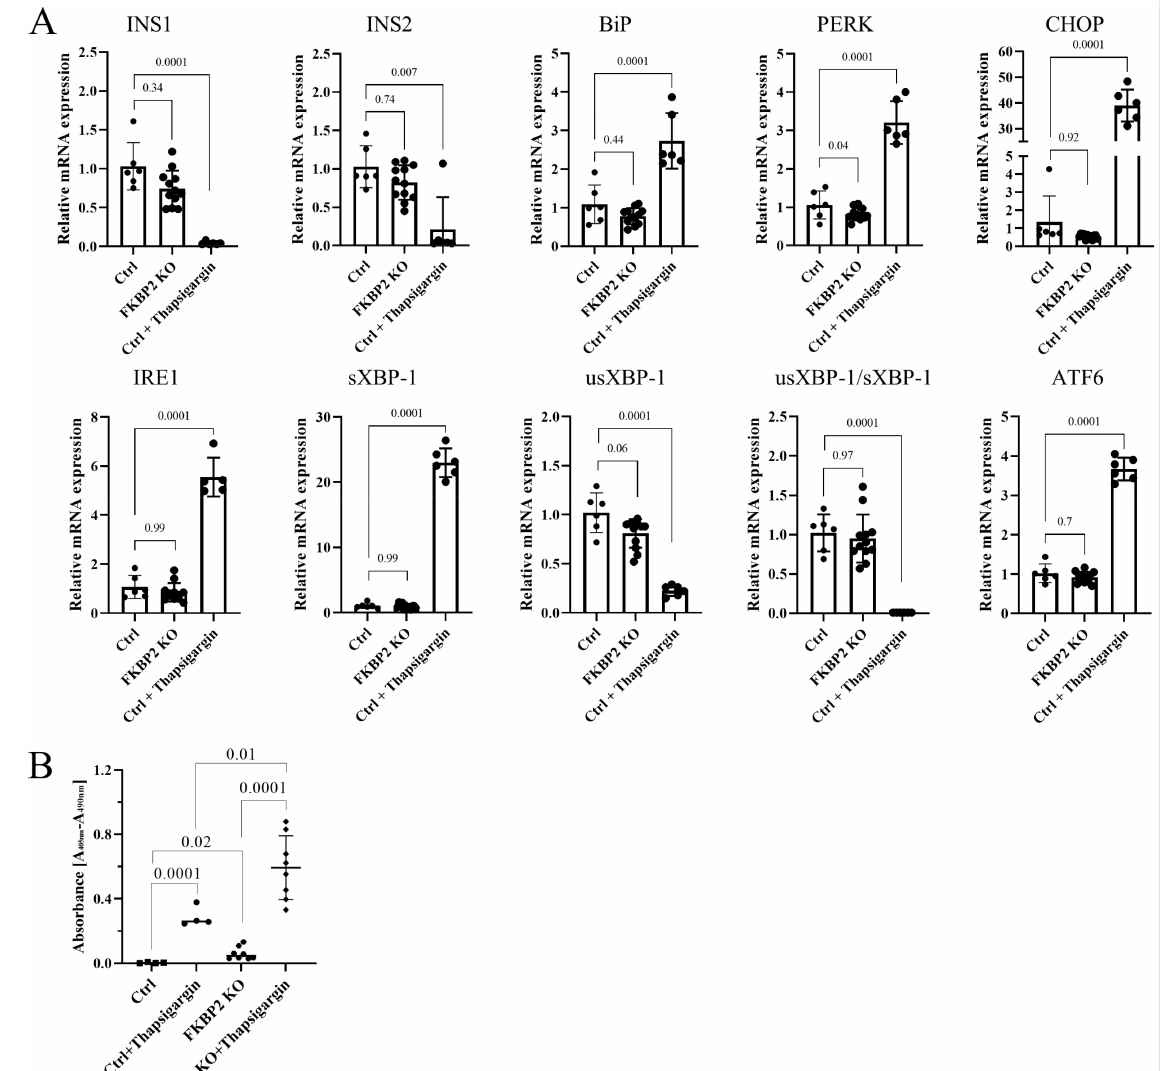
Figure 4. FKBP2 knockout does not induce endoplasmic reticulum stress but sensitizes cells to apoptosis. ( A ). mRNA levels of genes in the endoplasmic reticulum stress pathways were analyzed by quantitative reverse transcription-PCR (qRT-PCR) in Ctrl (FKBP2 WT cells) and FKBP2 KO cells. Data represent the mean ± SD analyzed by ordinary one-way ANOVA of treatments versus control, n > 6. ( B ). Apoptosis levels, representing internucleosomal degradation of genomic DNA, were analyzed in FKBP2 KO and Ctrl cells, n > 4. Where indicated, cells in A and B were exposed for 18 h to 0.7 µ M of